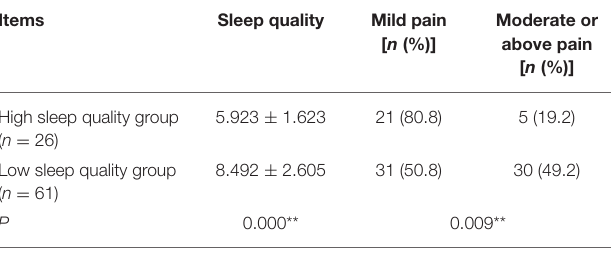
TABLE 3 | Sleep quality and pain degree of patients in two groups at 1 month after surgery ( n = 87).